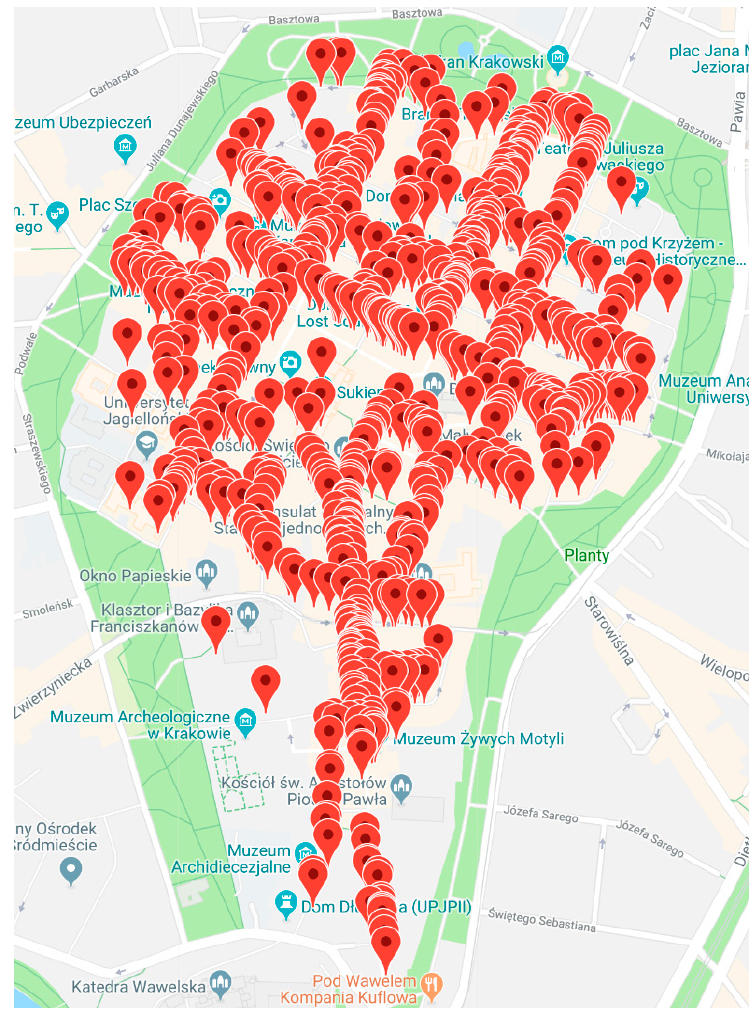
Figure 4. Locations of potential clients in the Old Town district of Krakow.